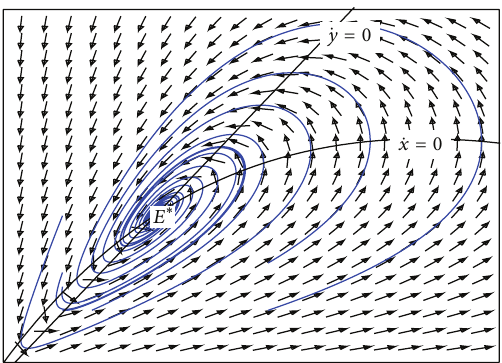
Figure 1: A vector graph of system (1): the black cure, ̇𝑥 = 0 , denote vertical isocline, and the black cure, ̇𝑦 = 0 , denotes horizontal isocline. The blue cures denote the trajectory in system